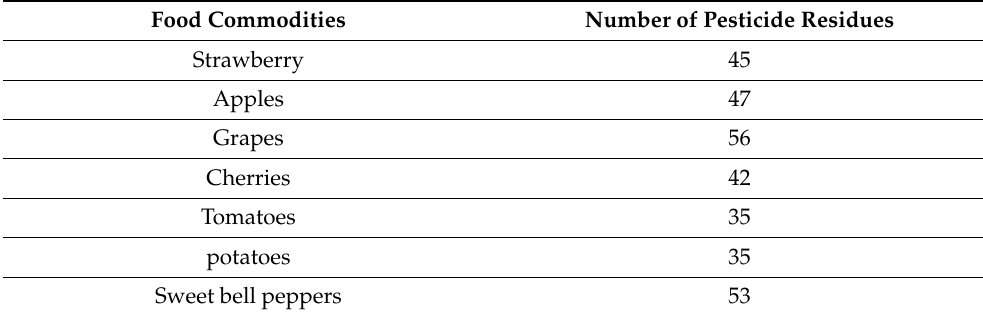
Table 1. The maximum number of pesticides found in various fruits and vegetables. Food Commodities Number of Pesticide